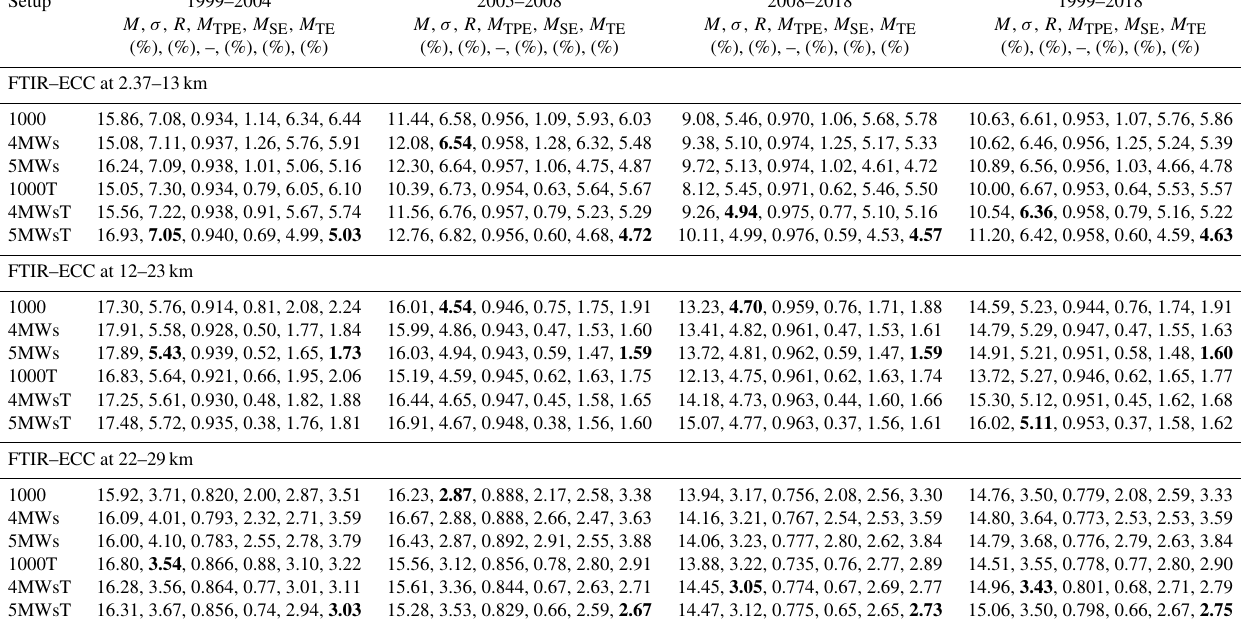
Table 3. Same as Table 2, but for the FTIR–smoothed ECC comparison for the O 3 partial columns computed for 2.37–13, 12–23, and 22– 29km. The number of coincident FTIR–ECC measurements is 56, 49, and 167 for the three periods, respectively, and 272 for the whole dataset. The strategies showing the best performance, in terms of smallest σ and M TE , are highlighted in bold for each period.